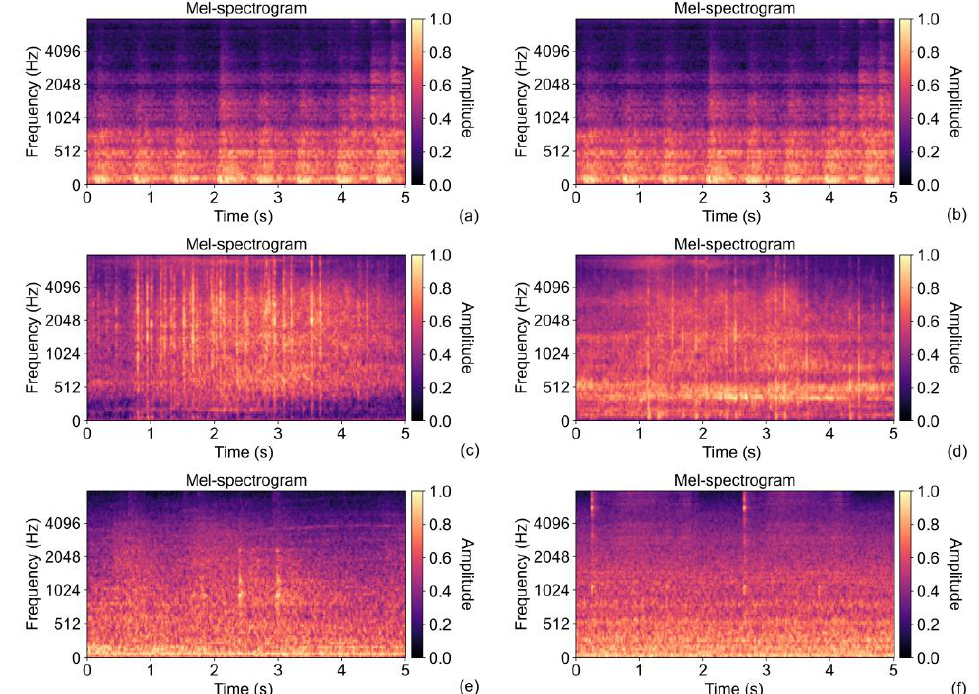
Figure 11. Mel-spectrograms of particular samples (machines) from toy-car, toy-train, fan, and valve classes within the extracted dataset: ( a ) toy-car number 67, ( b ) toy-car number 221, ( c ) toy-train number 74, ( d ) toy-train number 240, ( e ) fan number 150, and ( f ) valve number 238. Table 4. Intraclass and interclass similarities of mel-spectrograms from Figure 11. Machine-Type